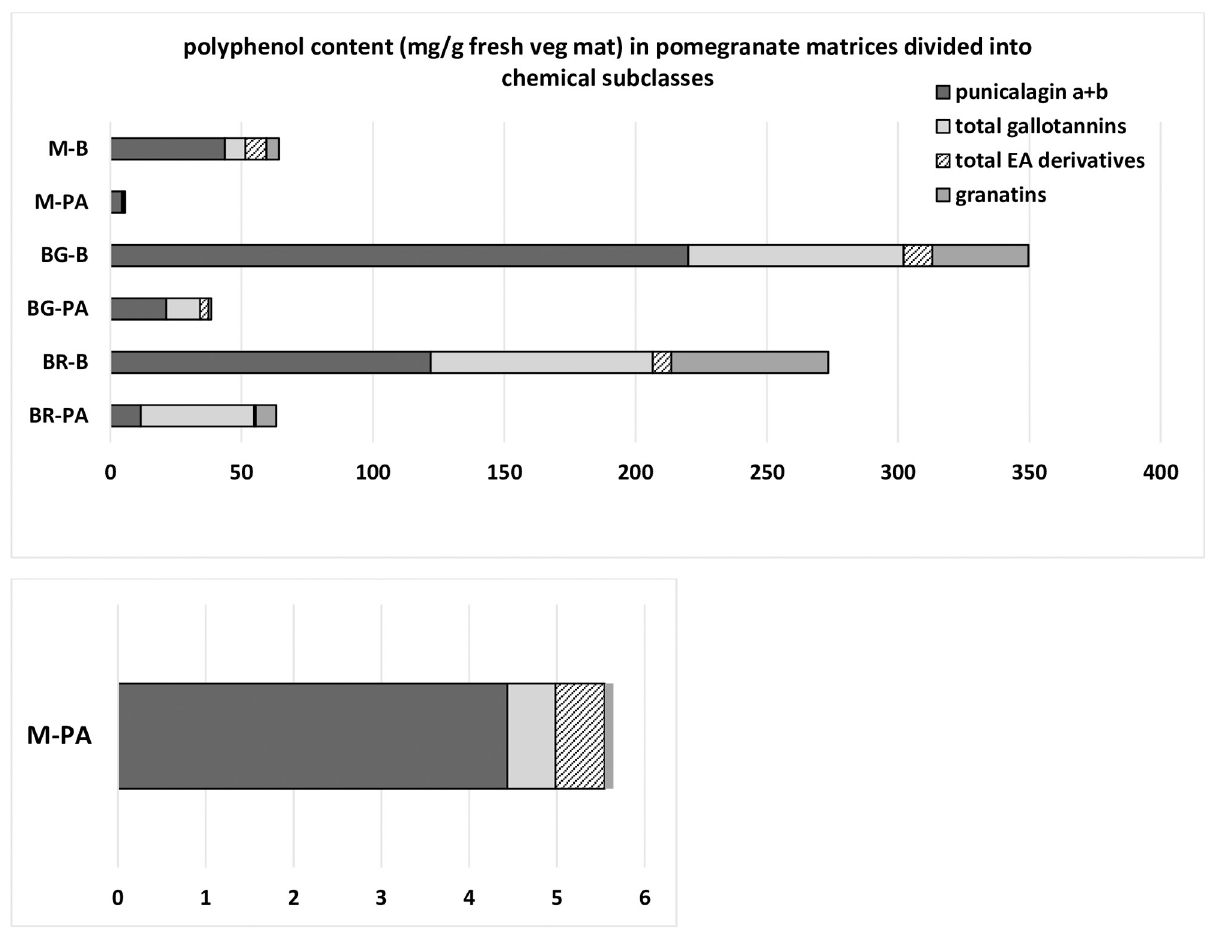
Fig 4. Polyphenol contents (mg/g of fresh vegetable material) of pomegranate matrices. Polyphenols were divided into chemical subclasses. BR-PA, BR-B, BG-PA, BG-B, M-PA and M-B correspond to extract labels as indicated in Fig 3. See also S1 Table for individual and collective quantitative data.